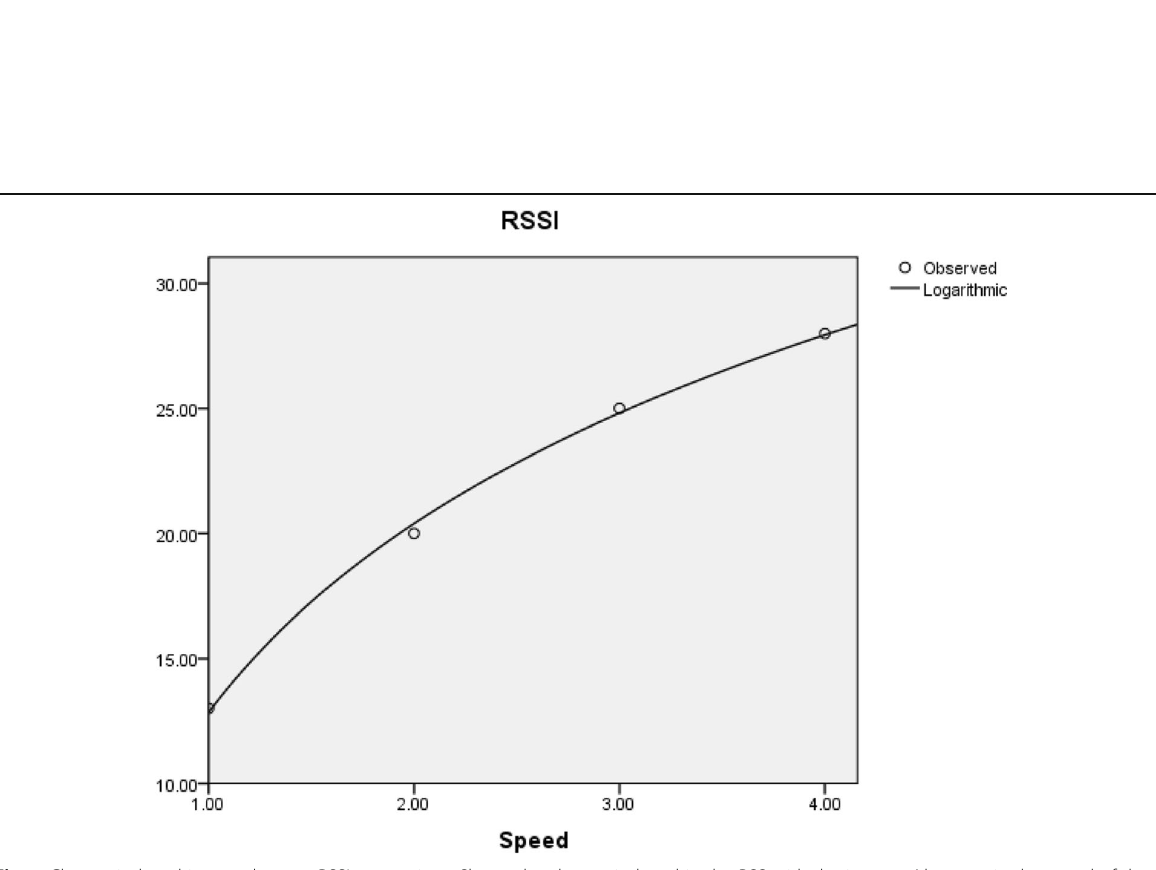
Fig. 7 Change induced in speed versus RSSI comparison. Shows the change induced in the RSS with the increase/decrease in the speed of the mobile nodes. The x -axis represents the speed of the mobile nodes in metres per second, while the y -axis represents the density of the RSS